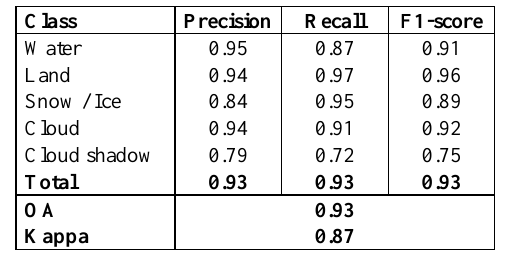
Table 1. Prediction results of the U-Net model for water segmentation on 358 test image tiles for Landsat TM, ETM+, OLI and Sentinel-2.